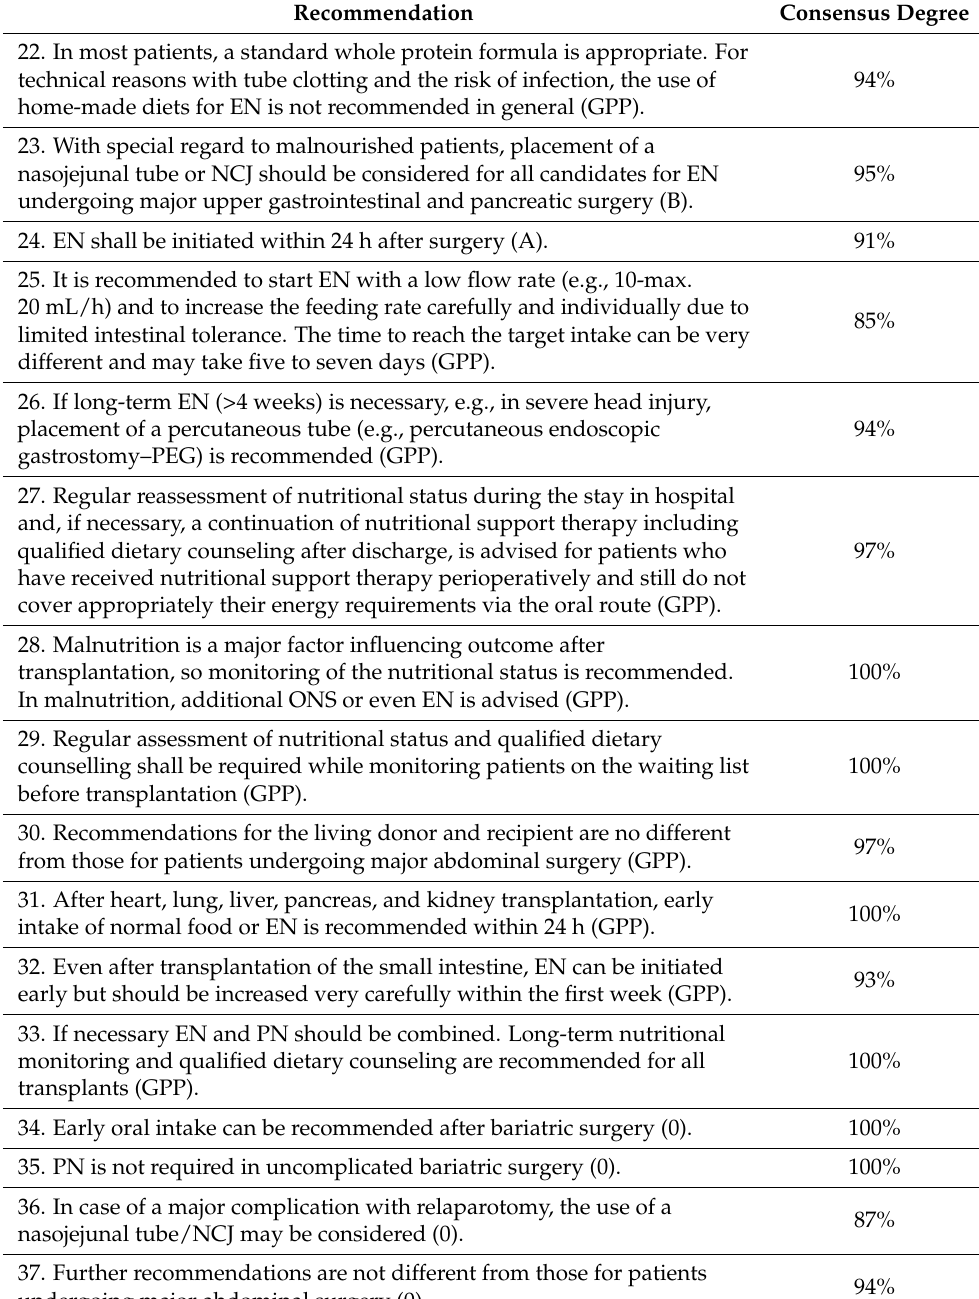
Table 1. Cont. Recommendation Consensus